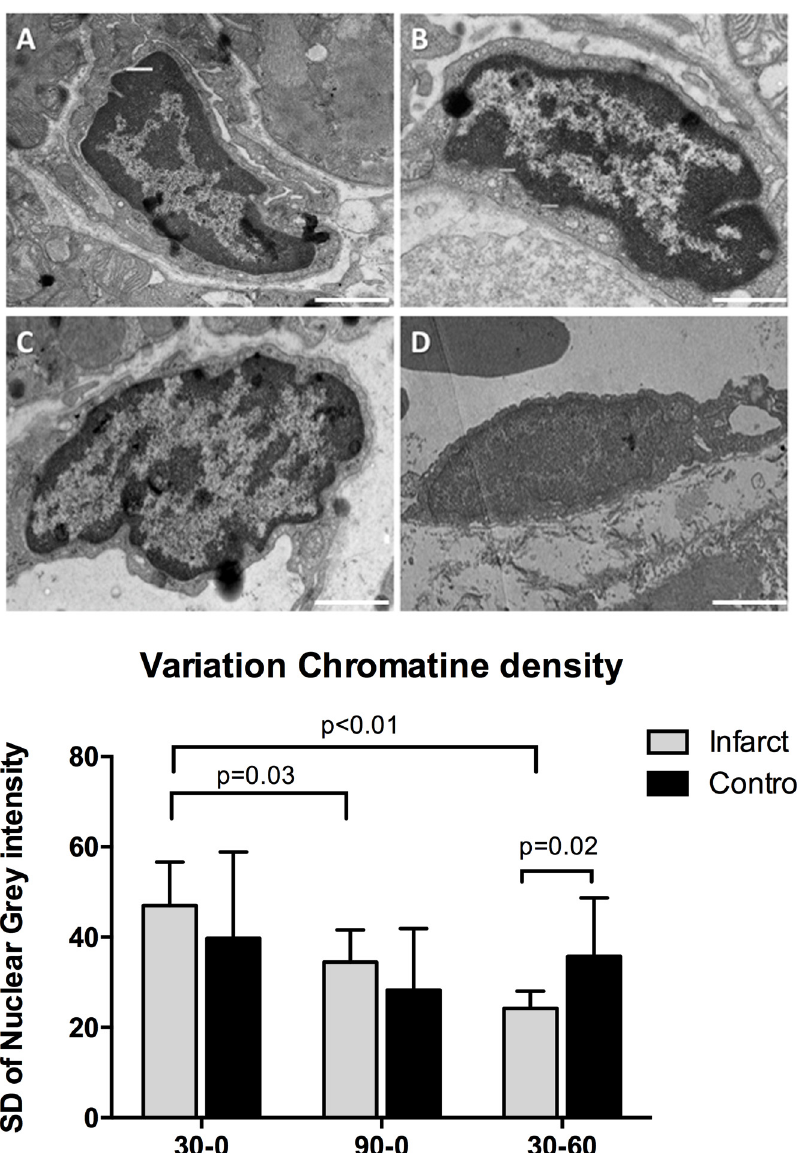
Fig 6. Endothelial cell nuclei characteristics. Top four images exemplify typical TEM images of infarct zone samples from different groups. A-D represent the control, and infarct zones of the 30 – 0, 90 – 0 and 30 – 60 group respectively. Magnification 12500x White bars represents 2 micrometer. E Quantification of chromatin density variation, using iTEM